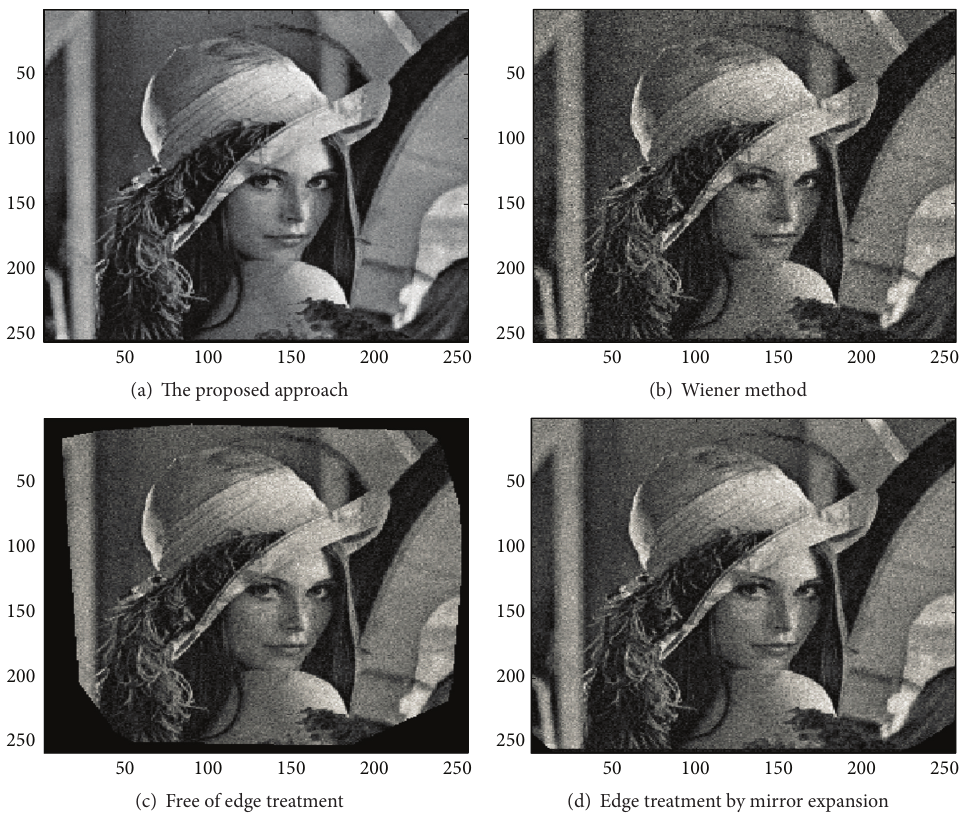
Figure 3: Comparison of denoising results for the image with Gaussian white